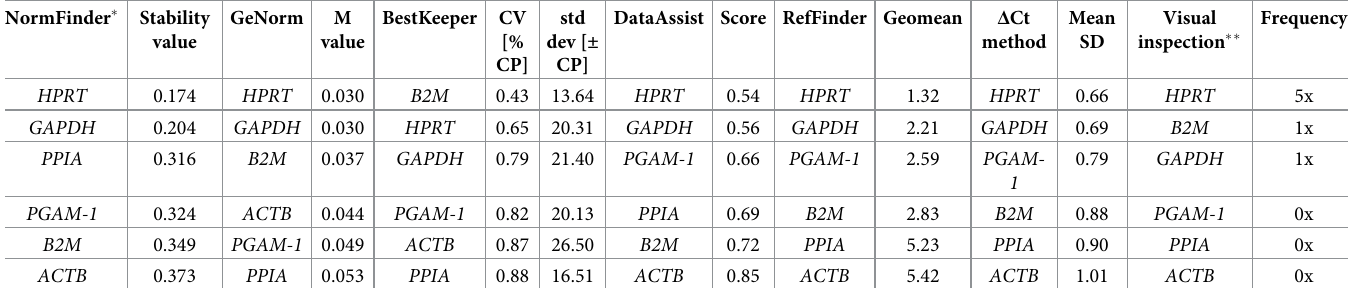
Lower values indicate increased stability in gene expression. Each software result is shown in order of stability. � Best reference genes determined by NormFinder when the intra- and intergroup variations were not considered. �� Visual inspection refers to the number of times each gene appears as the top gene in each